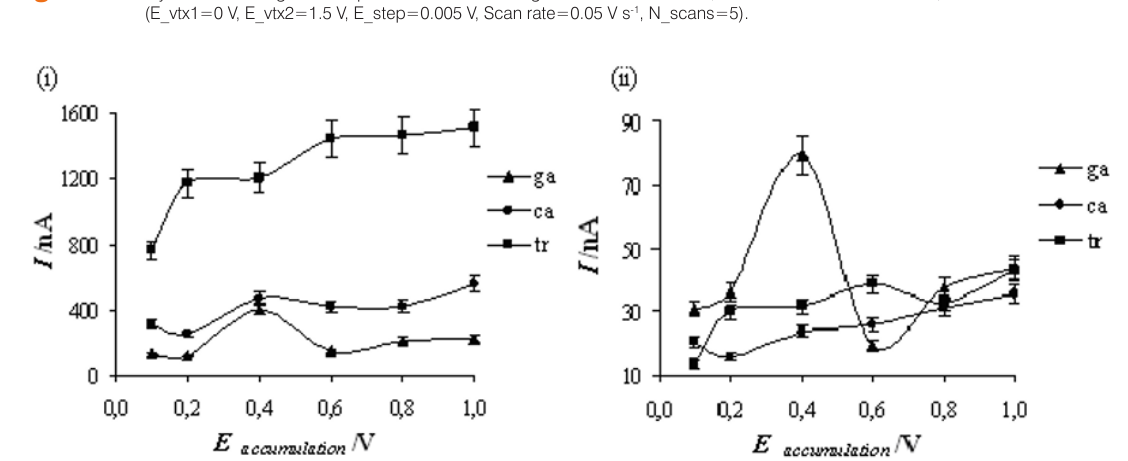
Figure 1. Cyclic voltammograms of phenolic acids. - - - gallic acid 10 -5 mol L -1 , …… caffeic acid 10 -5 mol L -1 ,